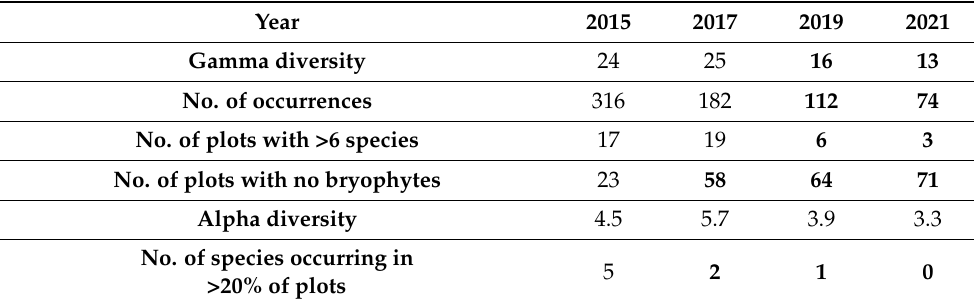
Table 2. Bryophyte diversity as sampled in 87 Sandhill Wetland plots between 2015 and 2021. Years with greater than 40% increase or decrease in bold font. Species names and occurrences are listed in Supplementary Table S1. Alpha diversity for individual years calculated as mean number of species in all plots with bryophyte presence in any given